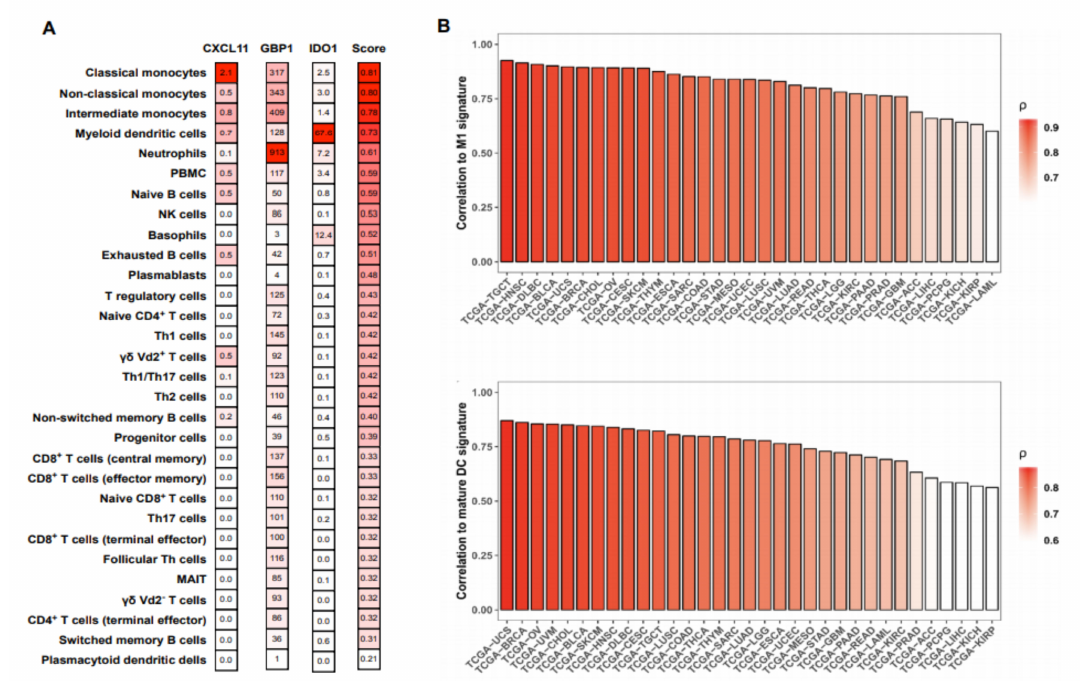
Figure 2. Expression of the myeloid activation (MA) signature genes positively correlated with M1 macrophage and ‘mature DC’ signatures in various cancer types. ( A ) RNA-seq data from peripheral blood mononuclear cells (PBMC) were obtained from GEO (GSE107011) and analyzed for the expression of the signature genes for every cell type available. Transcripts per million (TPM) values were scored with a non-parametric, rank-based method using the R package singscore based on the co-expression of Cxcl11 , Gbp1 , and Ido1. ( B ) Bulk tumor RNA-seq gene expression data was obtained from The Cancer Genome Atlas (TCGA ) cohorts using GDCRNATools in R. The MA signature score was compared to previously described M1 macrophage (upper panel) and mature DC (lower panel) signatures by Pearson correlation using R. X-axis represents TCGA study